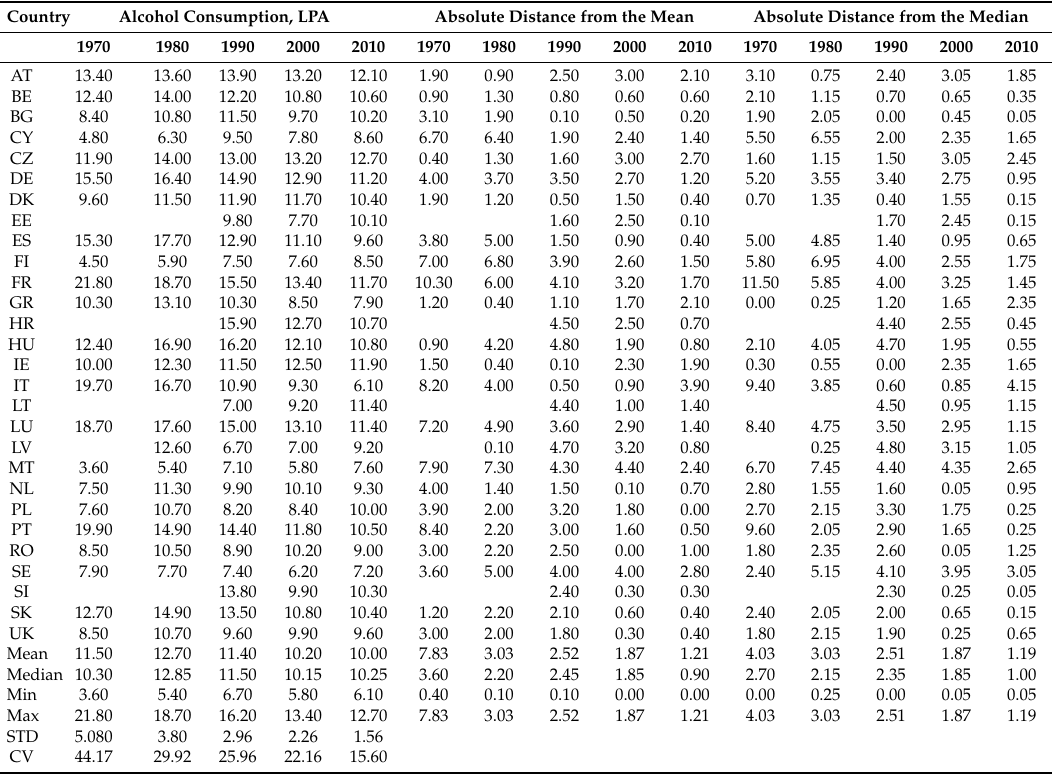
Table 2. Alcohol consumption in the EU: levels, descriptive statistics and dispersion. Country Alcohol Consumption, LPA Absolute Distance from the Mean Absolute Distance from the